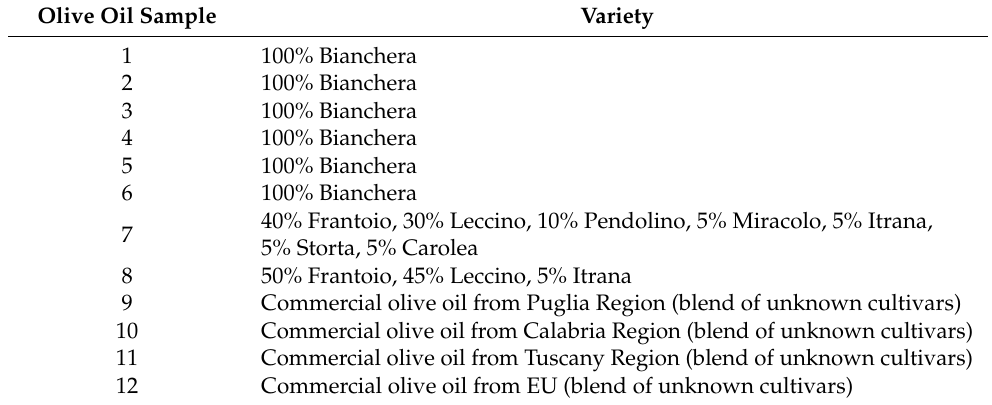
Table 3. Olive oil samples.